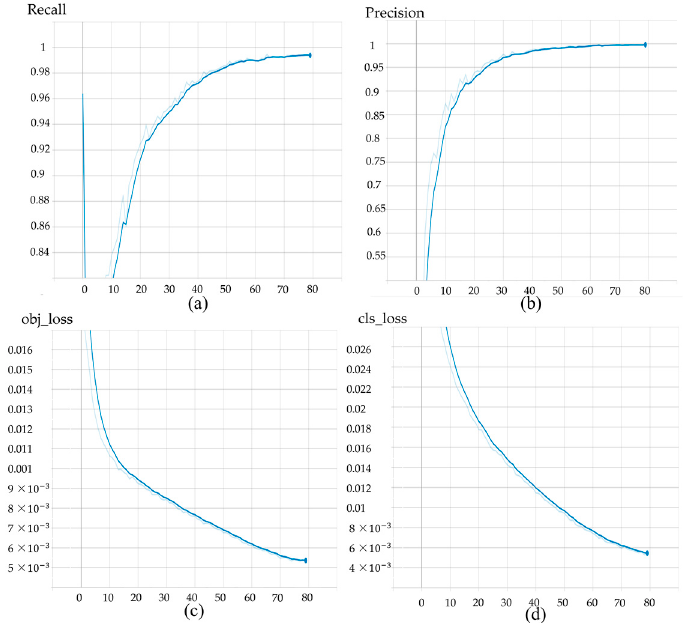
Figure 15. Indicator of training. ( a ) Precision trend in training. ( b ) Recall trend in training. ( c ) Ob